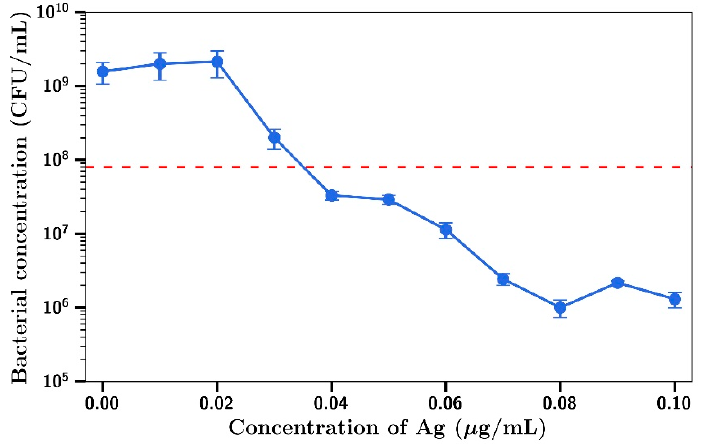
Figure 2. P. aeruginosa concentration at t = 4 h with 0.1 µg/mL gentamicin and varying Ag concentrations ( n = 3).